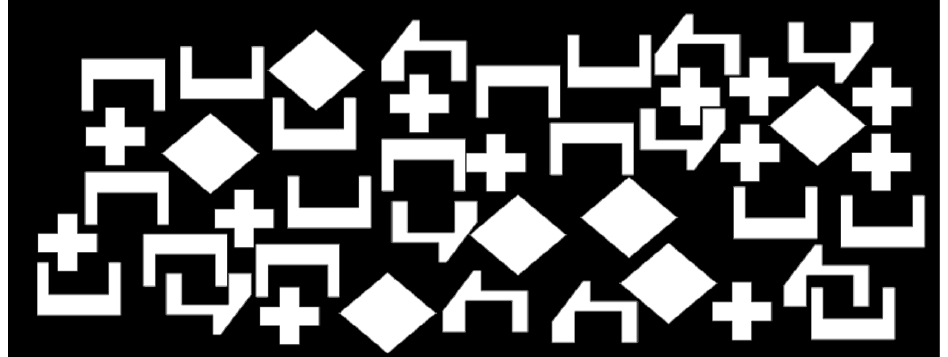
Figure 8. Solution found by the ILS algorithm using 43 pieces for the Shape 1 instance.